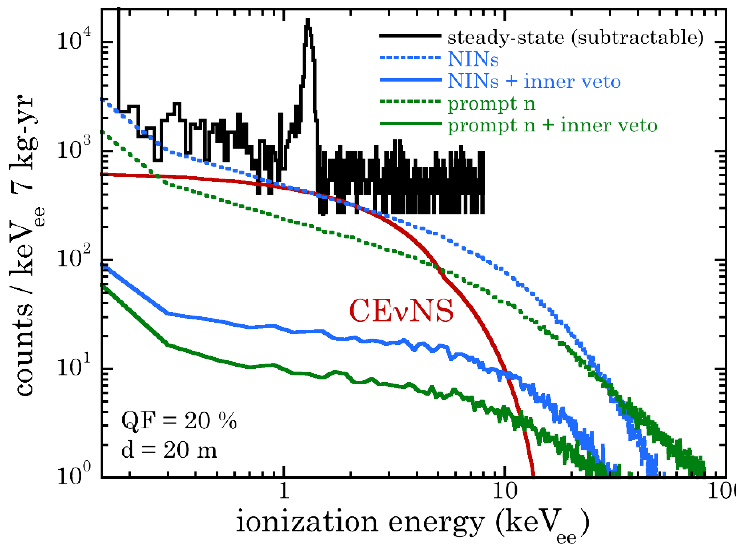
Figure 10 . Comparison of expected CE (cid:23) NS signal in Ge PPCs at the ESS to backgrounds. The beam-associated prompt neutron (cid:13)ux and NIN production rate are taken to be SNS [2], with same spectral hardness, in the simulations shown. The e(cid:11)ect of the inner veto uses as input its measured light collection e(cid:14)ciency, and a neutron response for plastic scintillator as in [117]. The subtractable steady-state background achieved at 6 m.w.e. with the PPC described in the text is shown, applying the ESS duty factor for a direct comparison to CE (cid:23) NS. As a